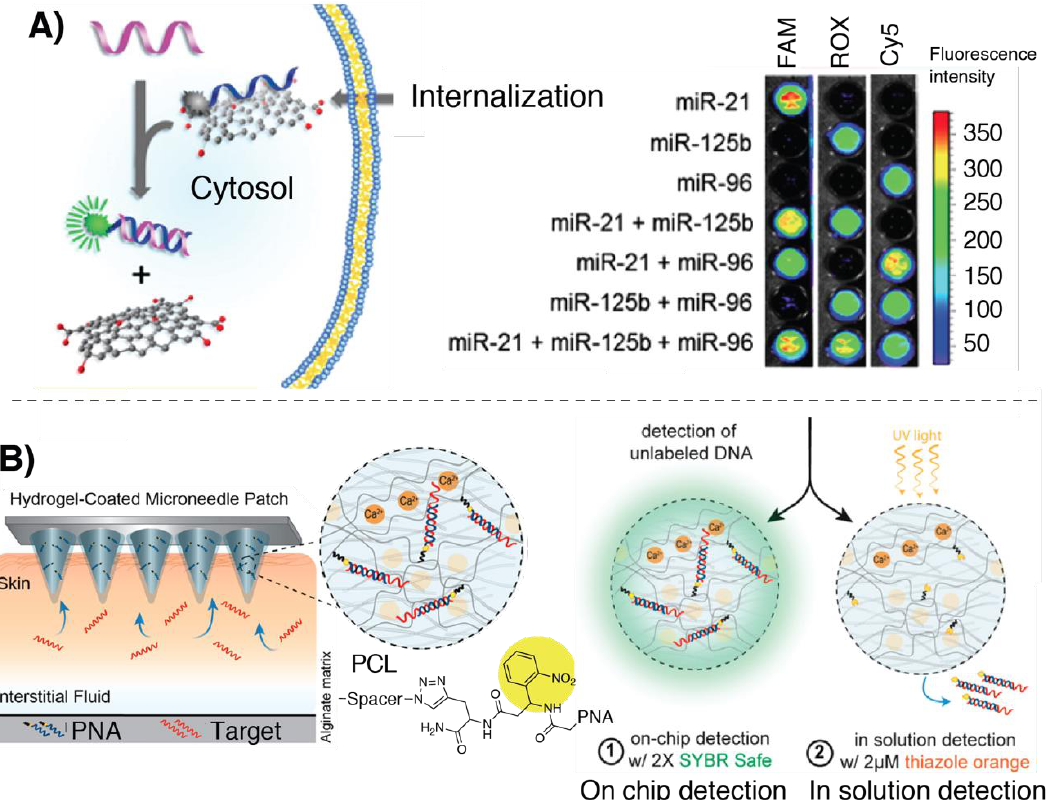
Figure 5. Illustration of some of the principal fluorescence-based methodologies for miR detection relying on PNAs hybridization. ( A ) Functioning of PNA–nano-graphene-oxide (PANGO) multiplexed analysis, adapted with permission from [82]. Copyright 2013 American Chemical Society. ( B ) Hydrogel-coated microneedle patch for sampling and detection of miR. Adapted with permission from [85]. Copyright 2019 American Chemical Society.